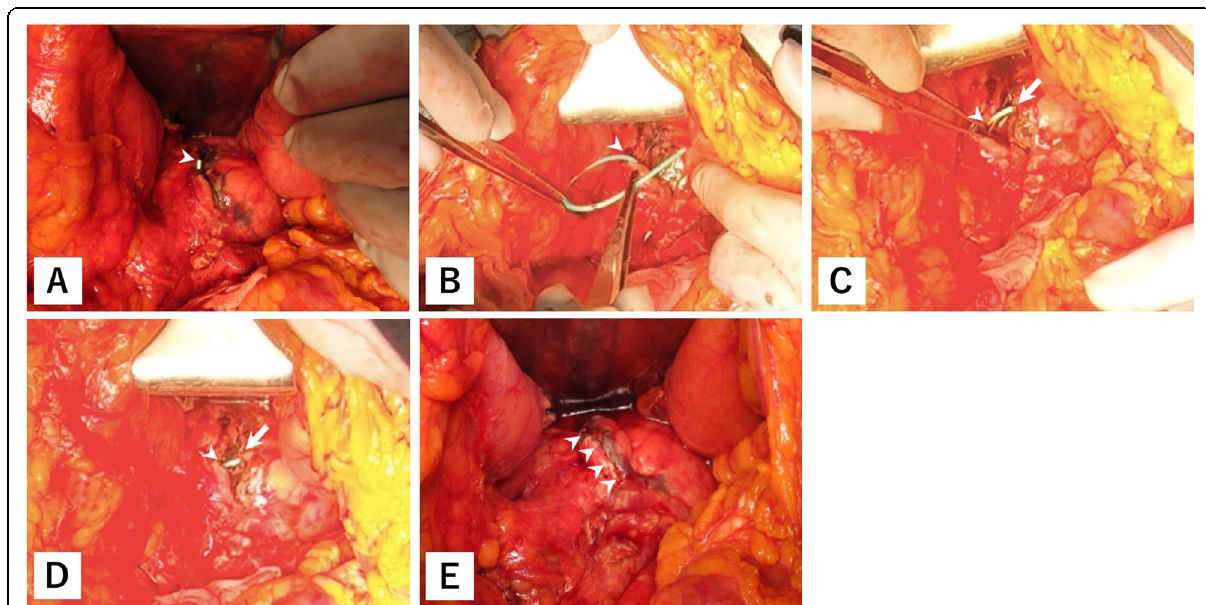
Fig. 3 Operative findings. A partial thickness laceration in the pancreatic body and the tip of the endoscopic nasopancreatic drainage (ENPD) catheter (arrowhead) was identified ( a ). We inserted the ENPD catheter into the distal (arrow) major pancreatic duct (MPD) segment from the proximal (arrowhead) MPD segment ( b – d ). The raptured MPD and laceration (arrowhead) were sutured ( e